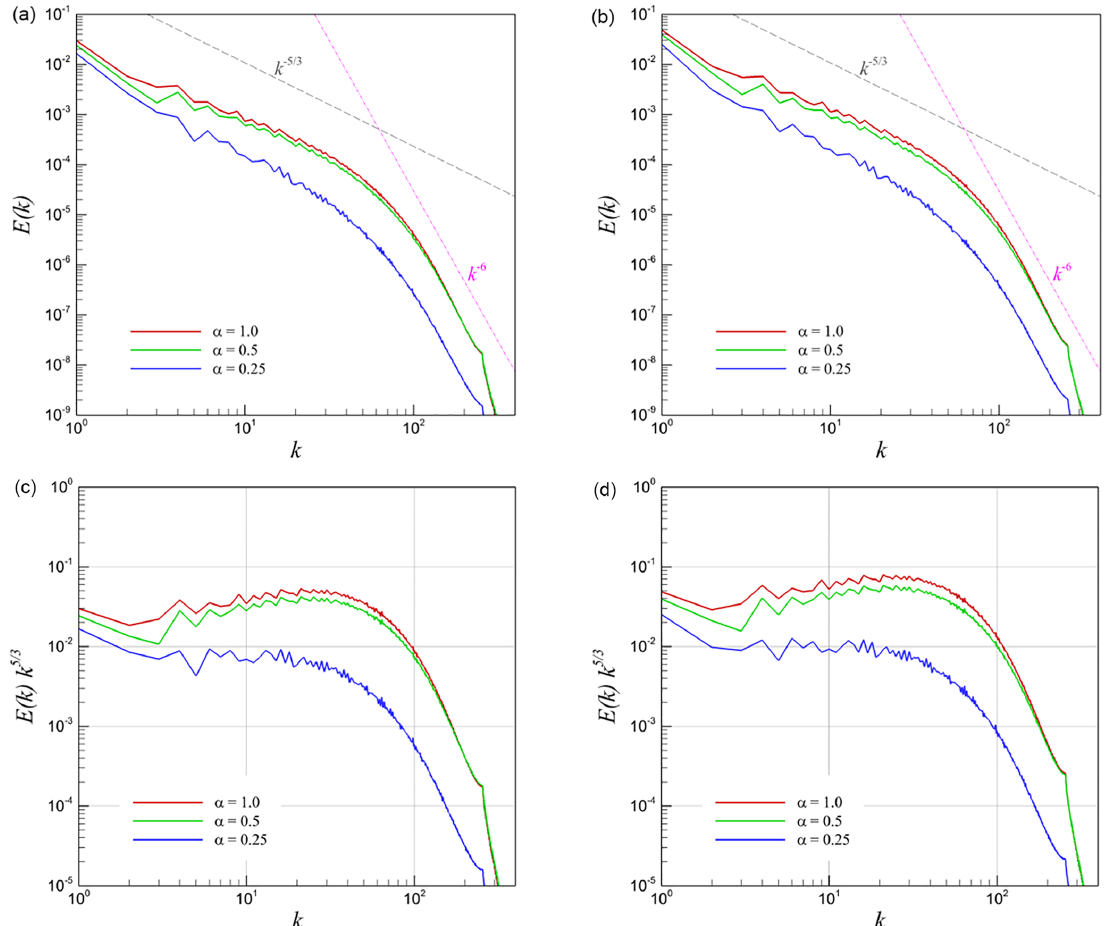
Figure 11. Transversely averaged energy spectra for 3-D KHI turbulence. An angle-averaged kinetic energy spectrum is first computed at each z plane using a 2-D FFT transform and then followed by a spatial averaging procedure along the z direction. (a) Spectra built on using the velocity u , (b) spectra built on using the density-weighted velocity ω = (d) compensated spectra built on using the density-weighted velocity ω =